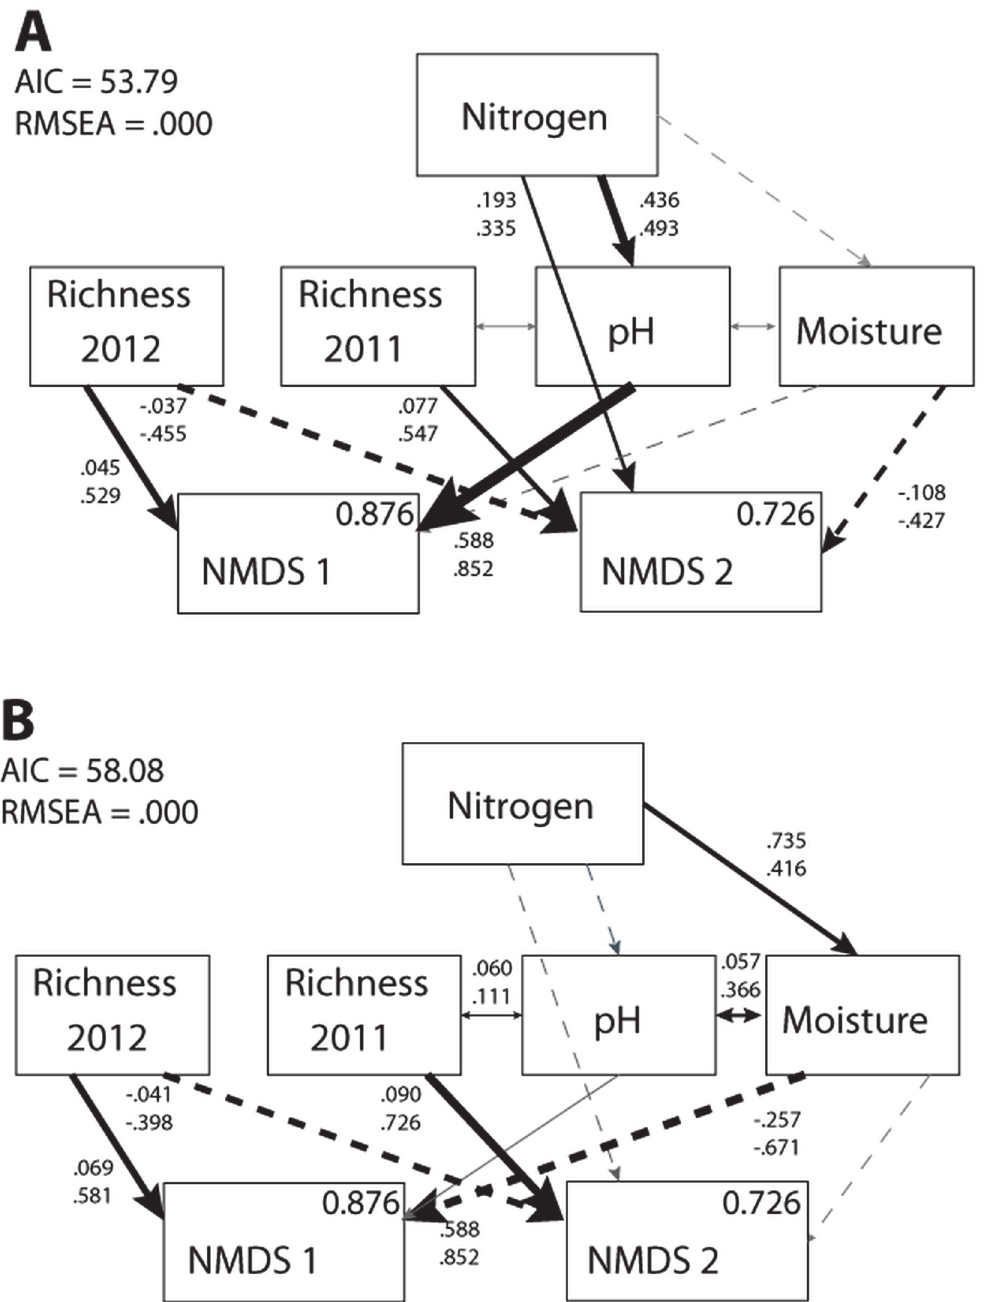
Fig 1. Results of the nitrogen SEM. Nitrogen effects on plant community NMDS scores in the (A) absence ( χ ² = 1.79, d.f. = 9, p = 0.994) and (B) presence of invasion ( χ ² = 6.08, d.f. = 9, p = 0.732). Black arrows with values indicate significant paths, gray arrows indicate insignificant paths, solid arrows indicate positive relationships, and dashed arrows indicate negative relationships. Path values indicate unstandardized (top) and standardized (bottom) coefficients. Within box values indicate R 2 values, which represent the proportion of variance explained for each response variable.